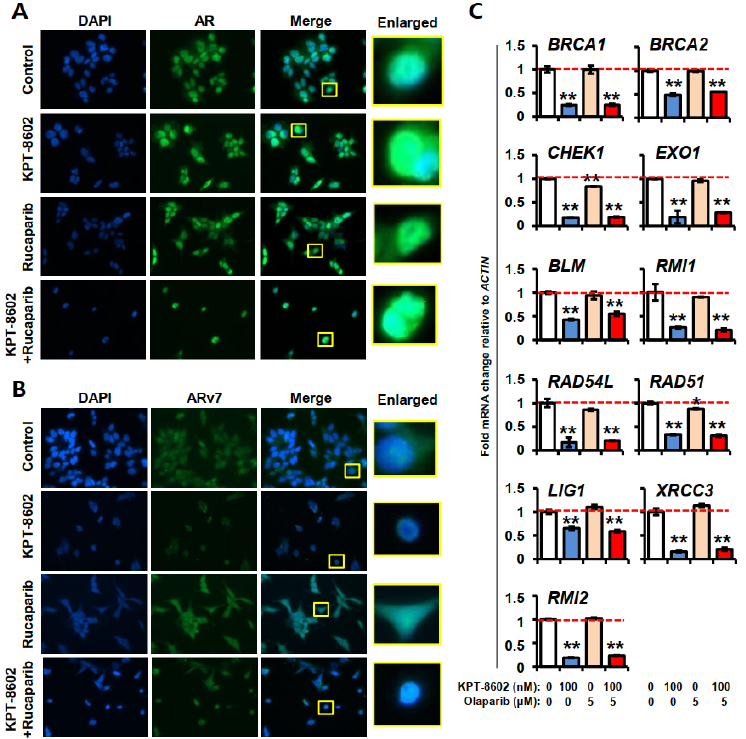
Figure 5. AR and ARv7 localization and DNA damage response of prostate cancer cells under KPT- 8602 and PARP inhibitors treatment. ( A , B ) Immunofluorescence (IF) analysis of AR and ARv7 in 22rv1 cells. Cells were grown in cell culture-treated chamber slides and treated with 2 µ M dose of KPT-8602 and 10 µ M dose of rucaparib alone or in combination. After 24h cells were fixed, permeabilized and stained with 1:600 and 1:100 dilution of AR and ARv7 (green) antibodies, respectively. Nuclei were stained with DAPI (blue). ( C ) Gene expression was determined after 24 h of treatment using real-time RT-qPCR. mRNA expressions of BRCA1 , BRCA2 , CHEK1 , EXO1 , BLM , RMI1 , RAD54L , RAD51 , LIG1 , XRCC3 and RMI2 in KPT-8602 and/or olaparib treated cells. Red dotted line indicates the expression level of the control. Doses for KPT-8602 and olaparib were 100 nM and 5 µ M, respectively. Experiments have been done in triplicate. Error bars represent standard deviation. * p < 0.05; ** p <